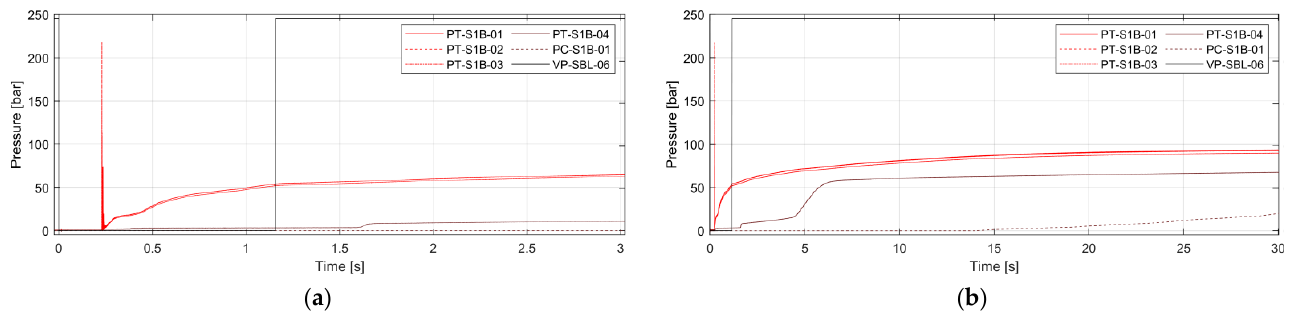
Figure 10. Pressure time trends in S1B reaction vessel and valve position. ( a ) zoom on [0–3] s, ( b ) zoom on [0–30] s.